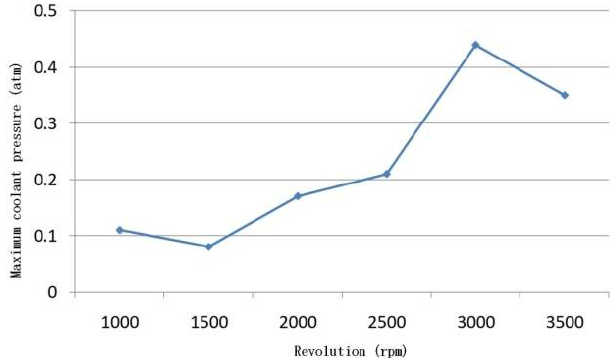
Figure 15. Frequency response curves of water jacket models with different impedance boundaries.